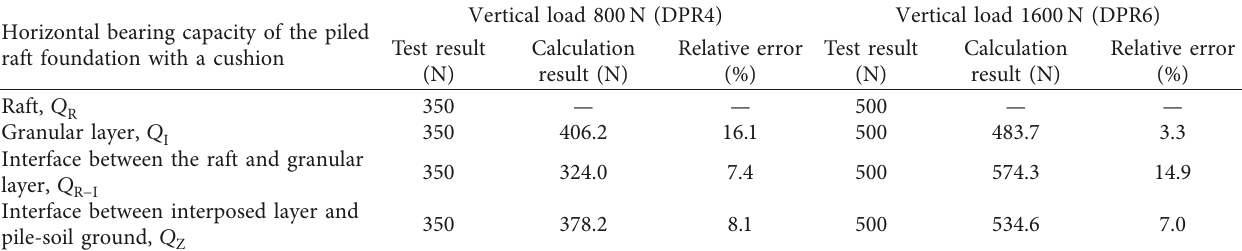
Table. 4: Comparison of the calculation and test results on the horizontal bearing capacity of the DPR foundations. Horizontal bearing capacity of the piled raft foundation with a